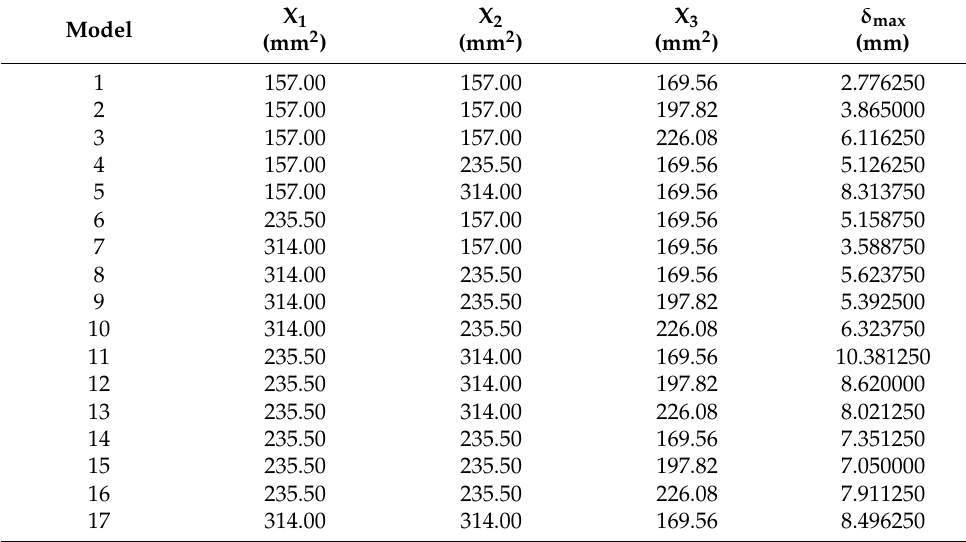
Table 12. Optimization results for maximum